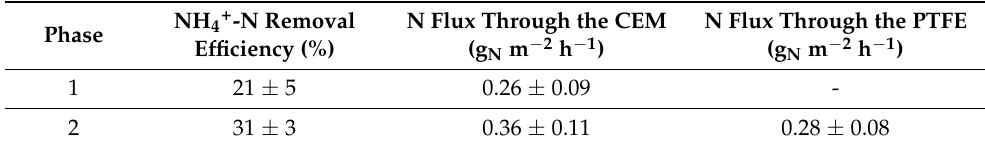
Table 3. Average values for current density, COD and ammonia removal efficiencies, and nitrogen flux transfer through the